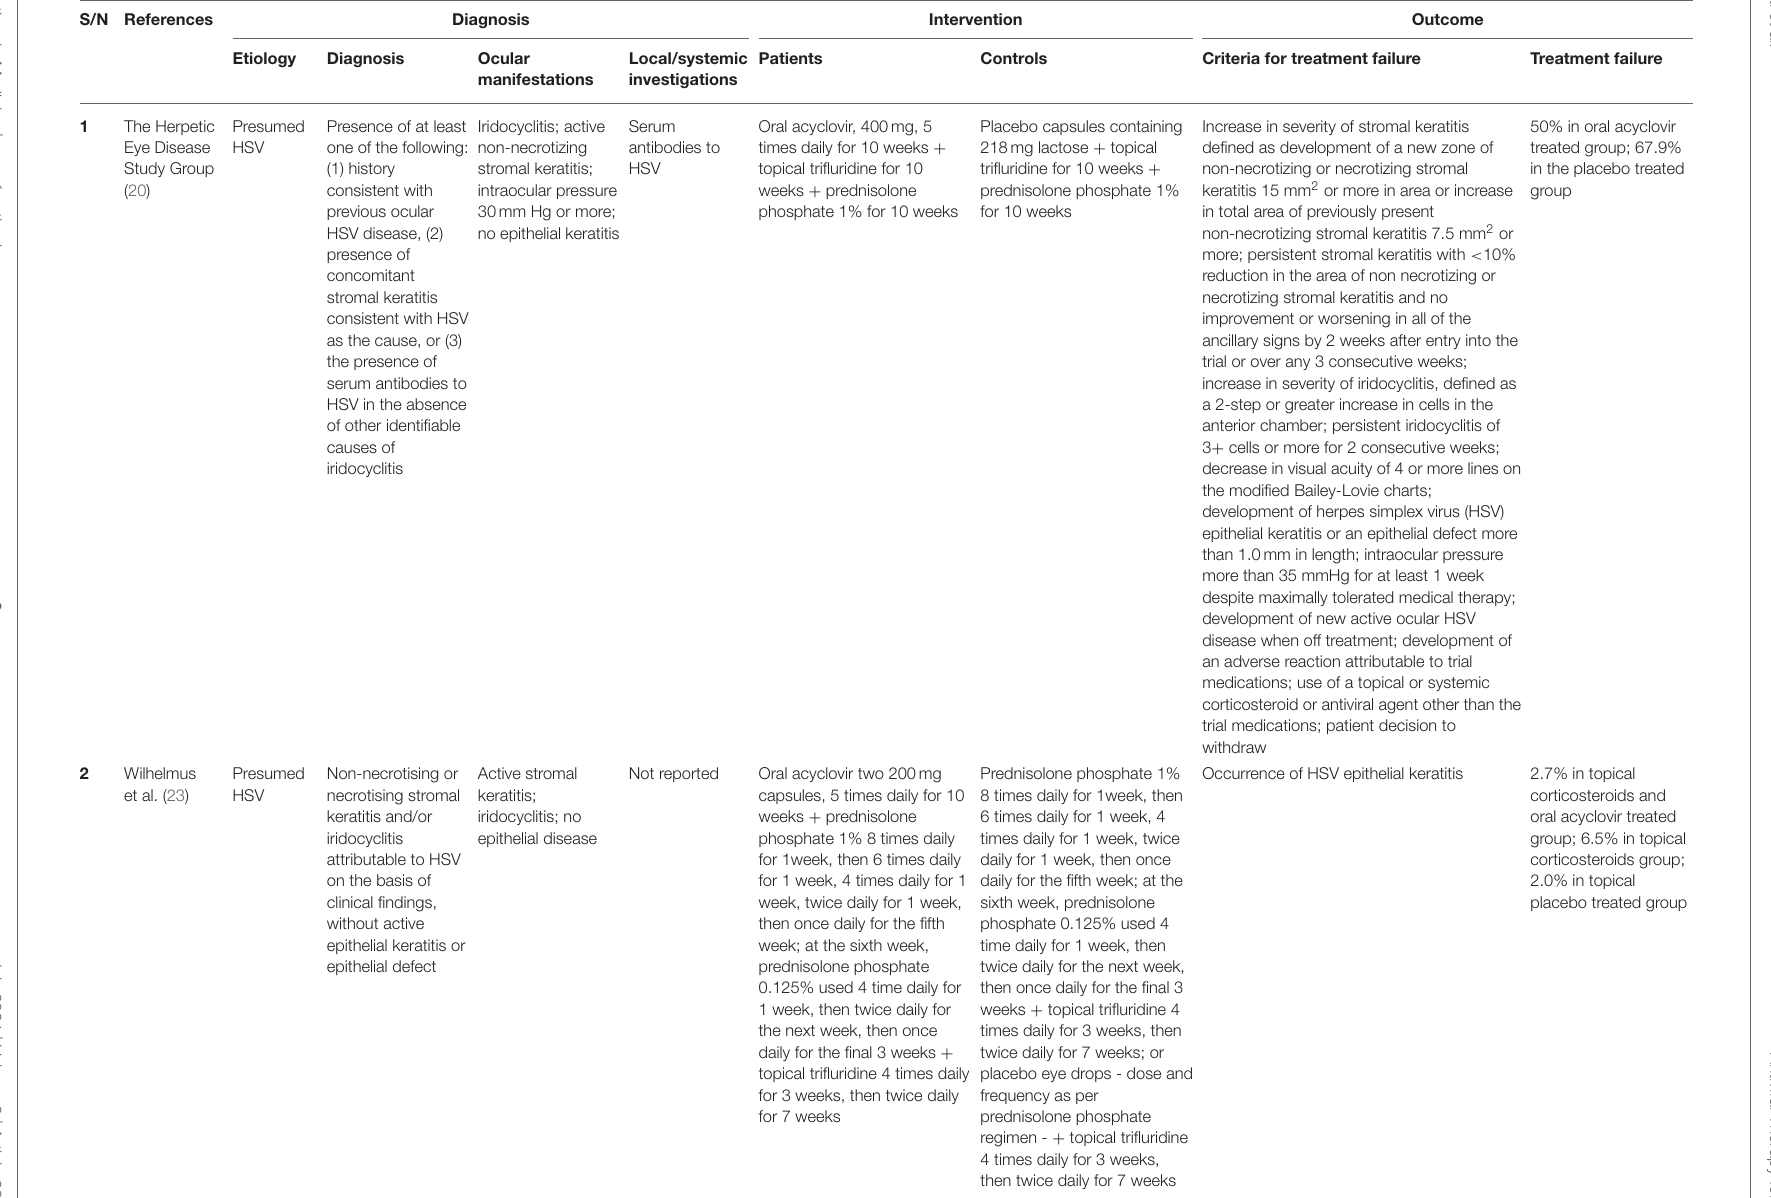
TABLE 2 | Diagnosis, intervention,